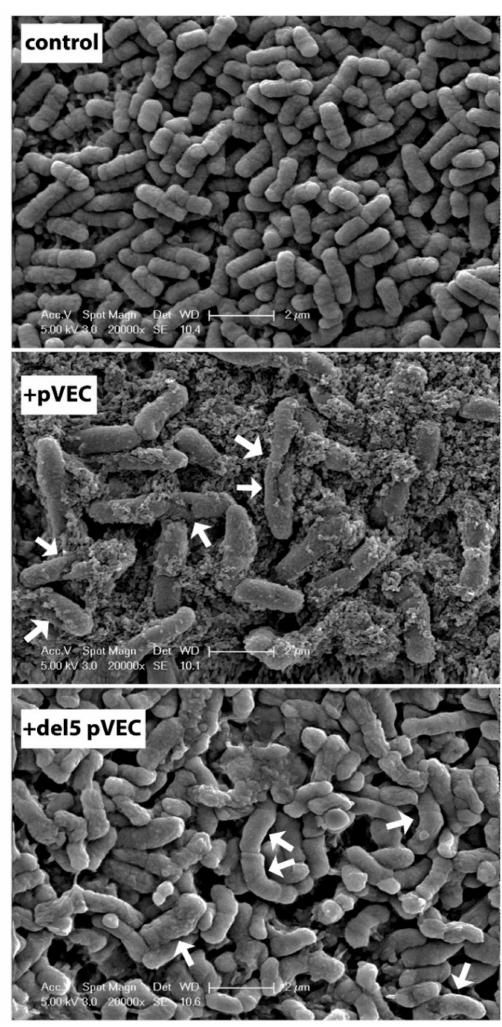
Figure 7. SEM imaging of Escherichia coli cells on membrane filters. Untreated E. coli cells (top), E. coli treated with MIC of pVEC (middle), and with 500 µ M del5 pVEC peptide (bottom). Changes in surface structure due to peptide treatment are indicated by arrows (Reproduced with permission of the authors of a previous paper [279]).